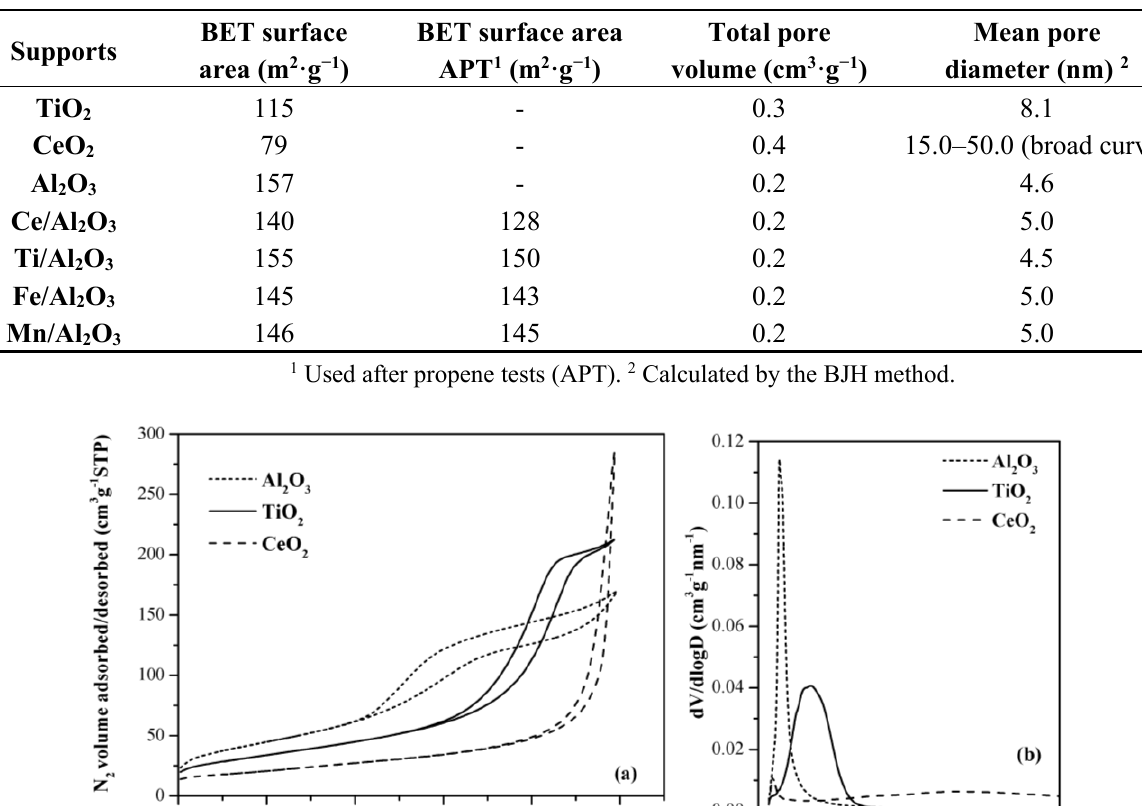
Table 1. Physicochemical properties of the supports.